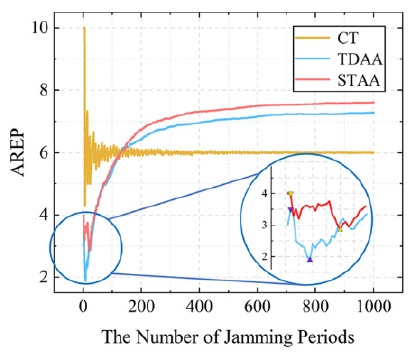
Figure 6. Schematic diagram comparing the AREP between continuous transmission (CT), the TDAA [11], and the STAA.